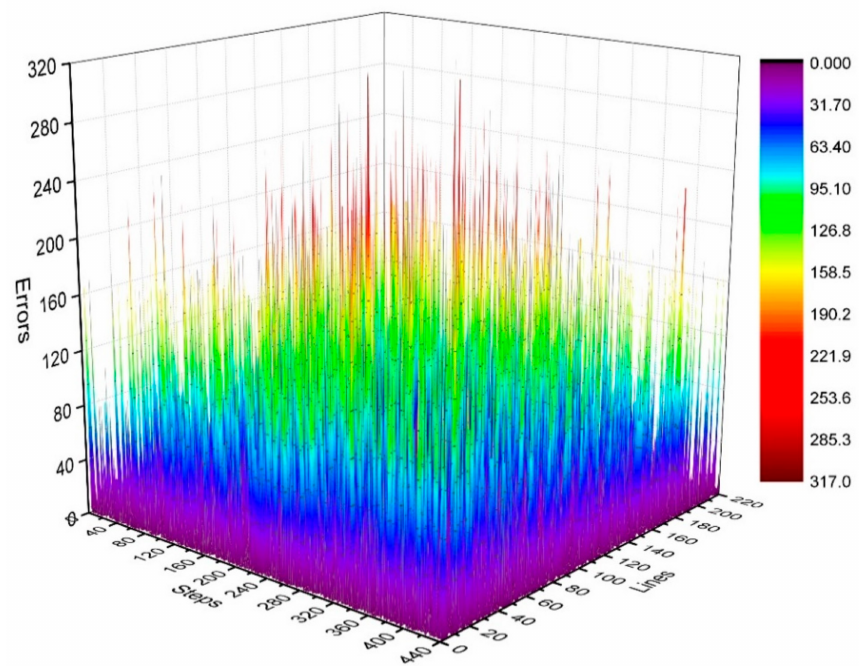
Figure 5. Three-dimensional statistical diagram of phase difference (error) distributions of K τ and K τ − 6 .